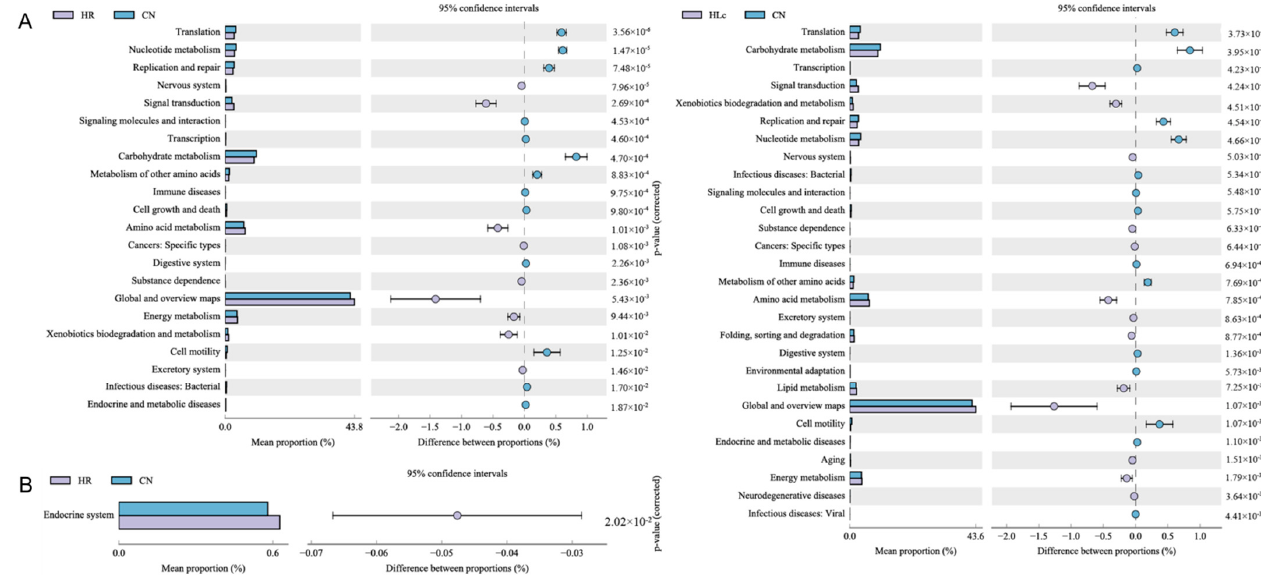
Figure 6. The Effects of Lactobacillus casei and anti-TB drugs on KEGG pathways. Imputed metagenomic differences between two groups based on Welch’s t -test ( p < 0.05). The colorful circles represent 95% confidence intervals calculated by Welch’s inverted method. ( A ) week 2; ( B ) week 6. n = 5 in each group, CN: control group, HR: isoniazid + rifampicin model group, HLc: HR + high dose L. casei ATCC334 group.